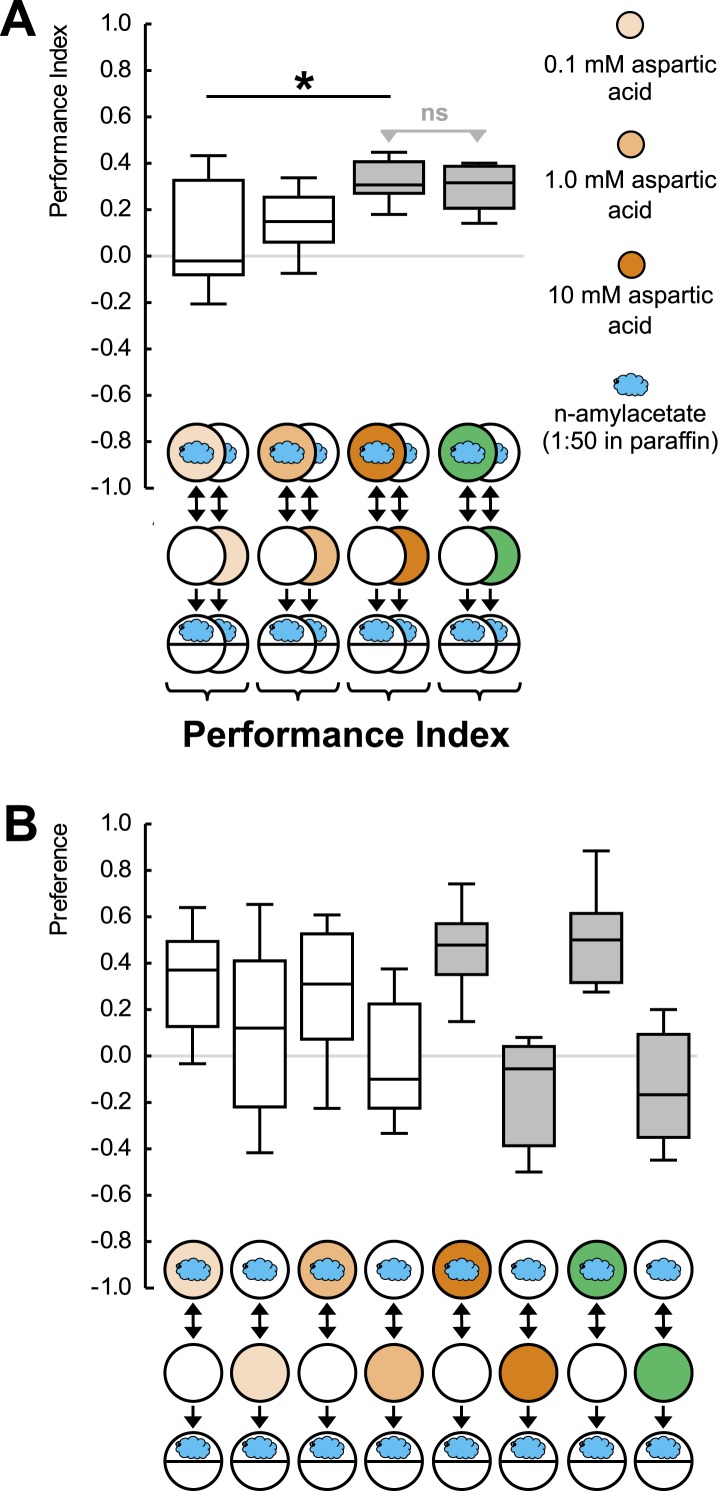
(A, B) Larvae are trained in a one-odor version of the learning paradigm, using different concentrations of aspartic acid as reward.Increasing the concentration increases the associative performance index. For the highest concentration used, levels of learned behavior are not different from those obtained with 2 M fructose as reward. (B) Preference scores underlying the associative performance indices in (A). Sample sizes: 11–17. Shaded boxes in (A) indicate difference from chance (p < 0.05/4, one-sample sign-tests), in (B) pairwise differences between groups (p < 0.05/4, Mann–Whitney U-tests). Asterisk: difference between groups (p < 0.05, Kruskal–Wallis test). For a detailed description of the sketches, see legend of Figure 1.